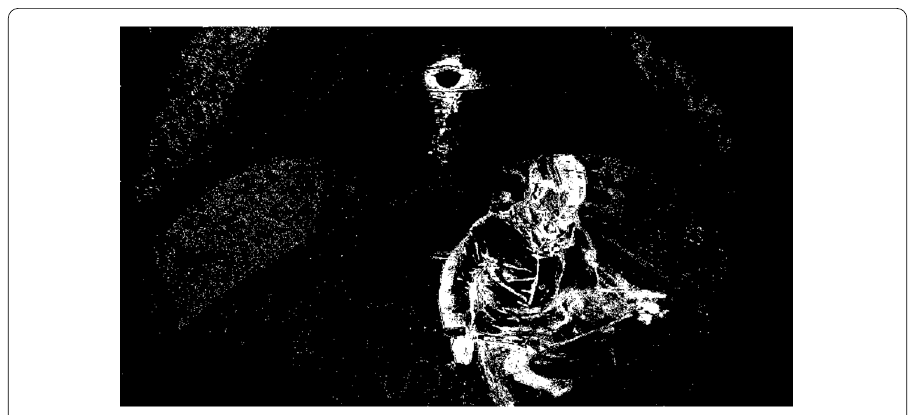
Figure 11 A foreground-background mask predicted by the GMM